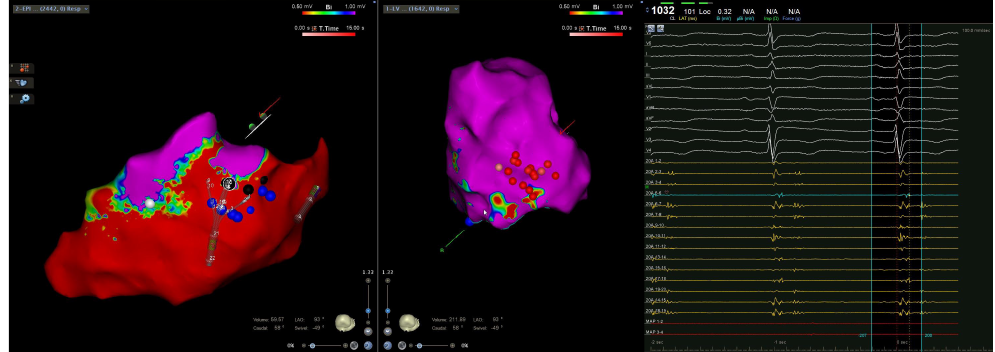
Figure 1. Intraprocedural CARTO three-dimensional left ventricular epicardial ( left ) and endocardial ( right ) electroanatomical multielectrode mapping displaying a predominantly epicardial inferior and inferolateral wall scar with limited endocardial involvement. Initial endocardial radiofrequency applications (red dots) were not effective in eliminating all the conduction channel entries (blue dots) observed during